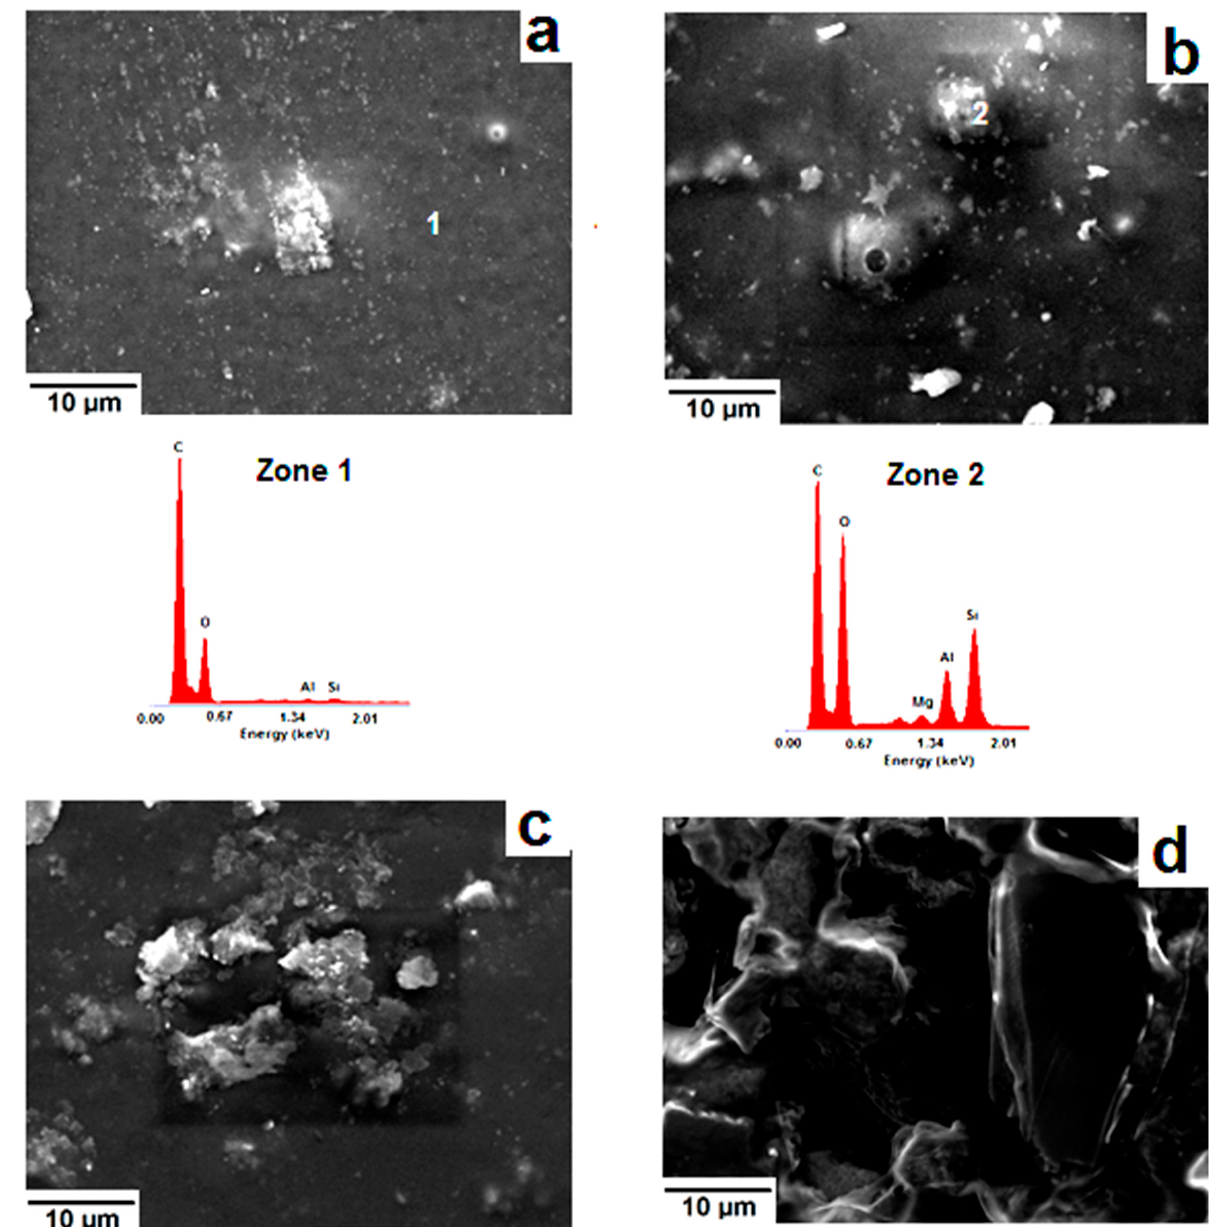
Figure 8. SEM micrographs of the montmorillonite-containing chitosan ( α / β ). ( a , b ) α -based films ( a ) 5 wt.%, ( b ) 25 wt.%); ( c , d ): β -based films ( c ) 5 wt.%, ( d ) 25 wt.%. Zone 1: EDS spectrum of the ( α -chitosan)-rich zone; Zone 2: EDS spectrum of the embedded montmorillonite aggregate.